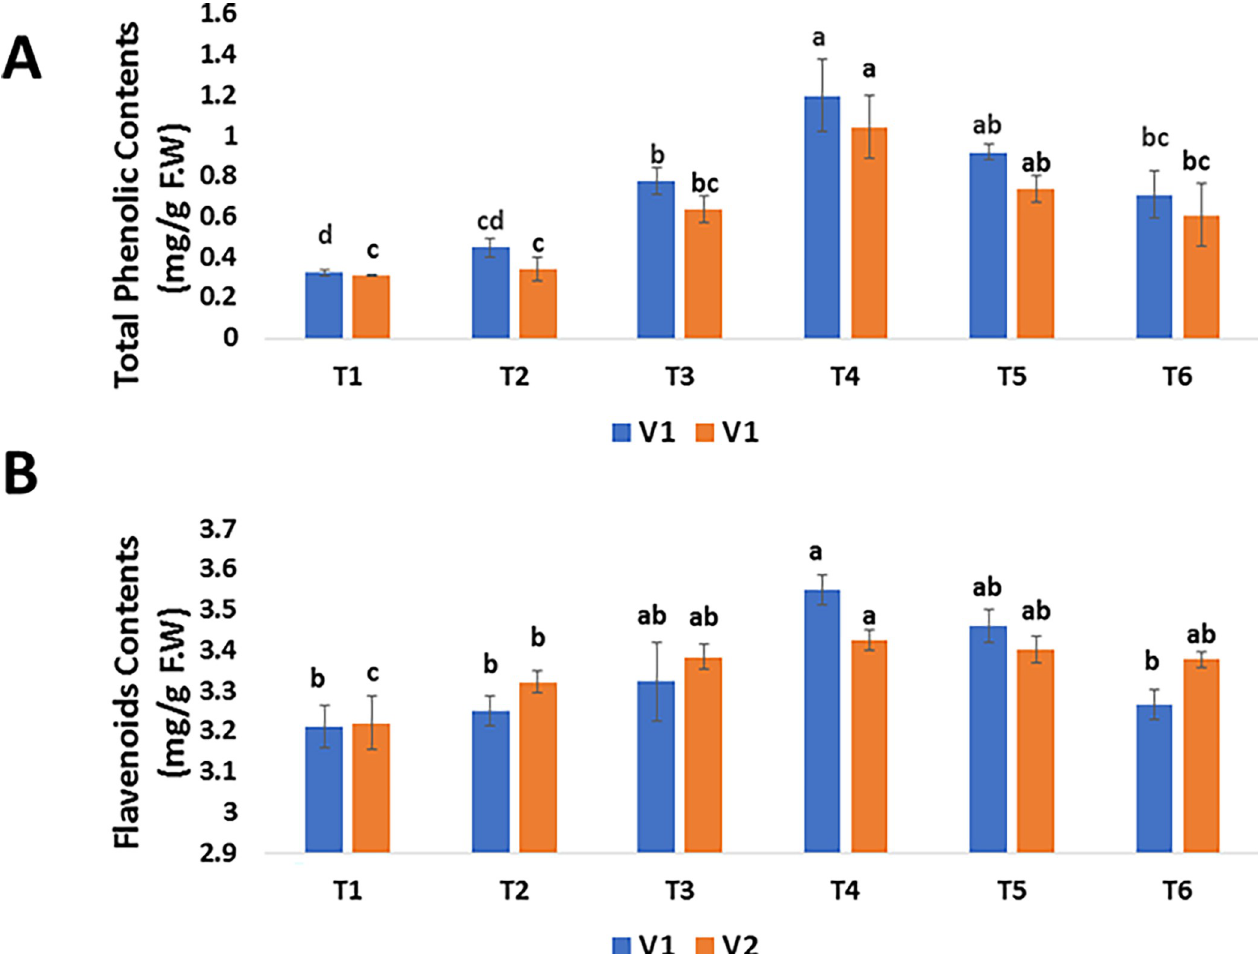
Fig 9. Effect of foliar applications of green synthesized SeNPs on biochemical parameters of Mangifera indica under the stress of mango malformation disease. (A) Total phenolic contents of M . indica in response to different treatments of SeNPs. (B) Total flavonoid contents of M . indica in response to different treatments of